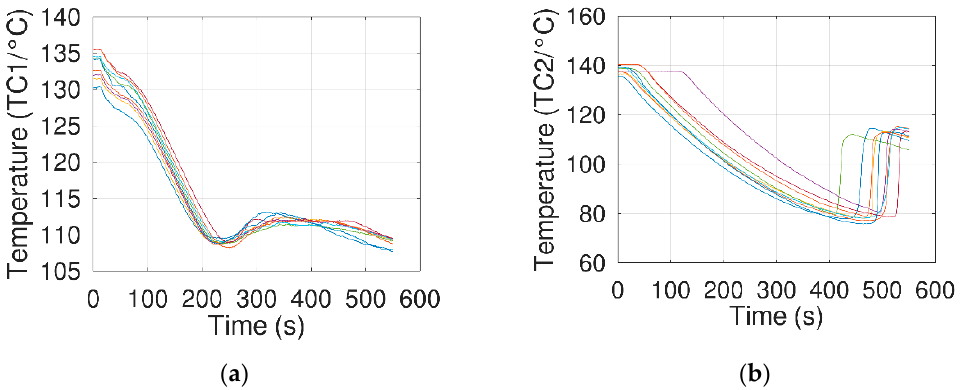
Figure 6. Thermograms obtained during free cooling without an electrical field (PRE01 to PRE09). ( a ) Thermocouple fixed to the electrode assembly (TC1) and ( b ) thermocouple fixed on the internal wall of the beaker (TC2). Table 4. Preliminary tests without applying a current.